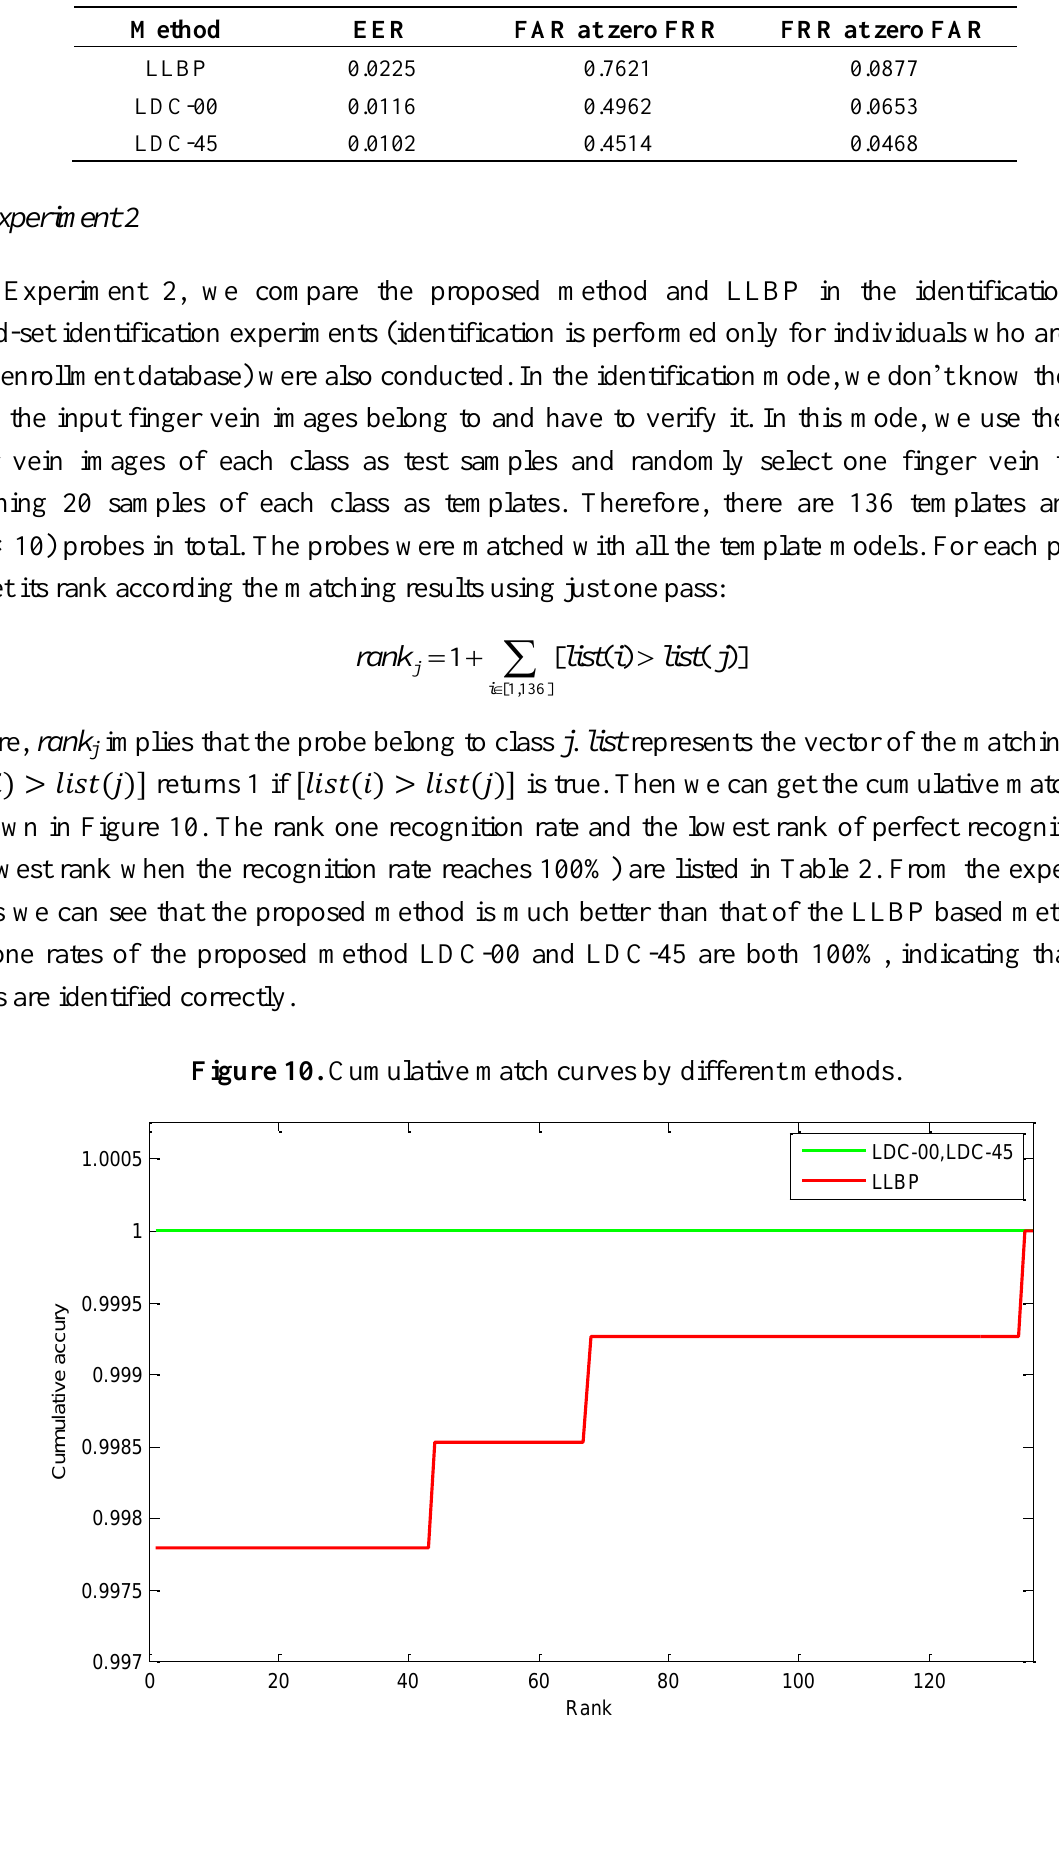
Table 1. Verification performance by different methods.